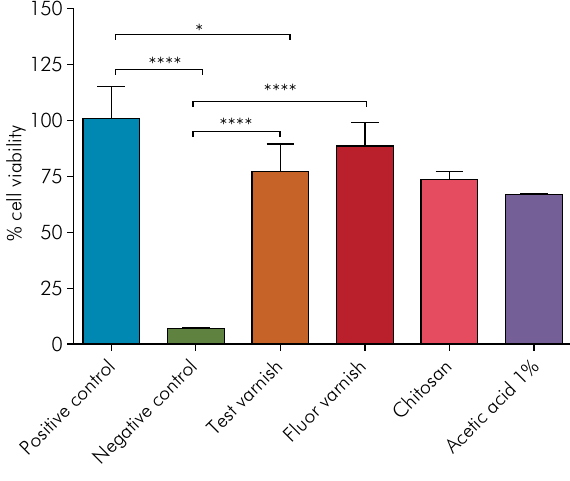
Figure 1. MTT-based viability assay of fibroblast culture after 24 hours in contact with the following materials: positive control (culture medium + cells); negative control (culture medium); test varnish (propolis varnish); fluoride-containing varnish (gold standard, Duraphat ® ); vehicle control (chitosan varnish); and 1% acetic acid. Four asterisks (****) indicate significant differences among the groups at p < 0.0001 (One-way ANOVA with Tukey-Kramer